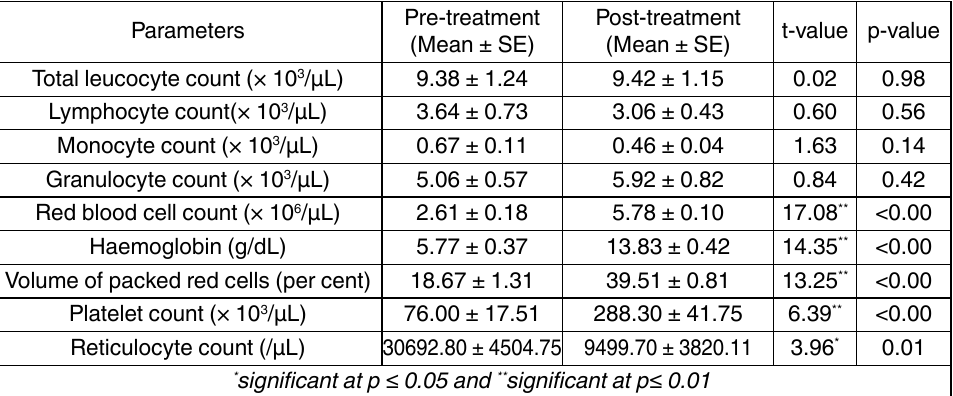
table 3 . Comparison of haematology and reticulocyte count before (day-0) and after treatment (day-21) of Group I